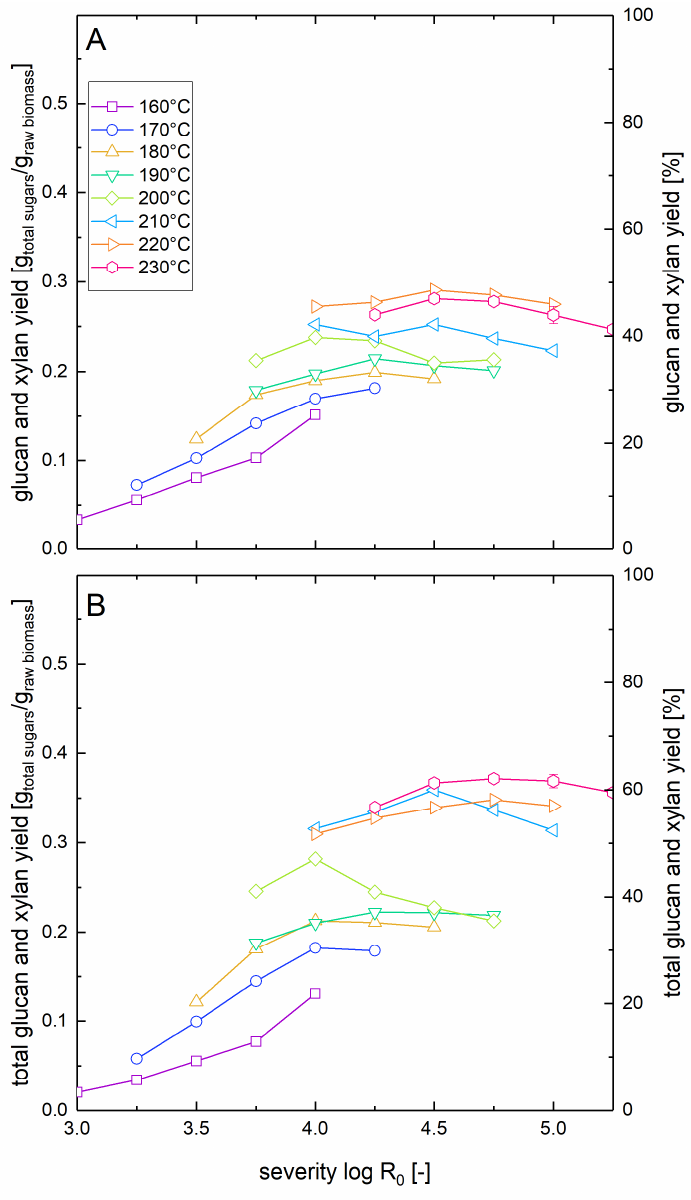
Figure 4. Total sugar yields after pretreatment and low solid enzymatic hydrolysis. The solubilization and recovery of glucan and xylan as soluble molecules after pretreatment and enzymatic hydrolysis was determined ( A ) after whole slurry enzymatic hydrolysis or ( B ) after combined enzymatic hydrolysis of washed solids and separate acid hydrolysis of the prehydrolyzate as a function of the pretreatment severity. A glucan loading of 1% based on the unpretreated biomass was applied in enzymatic hydrolysis experiments.